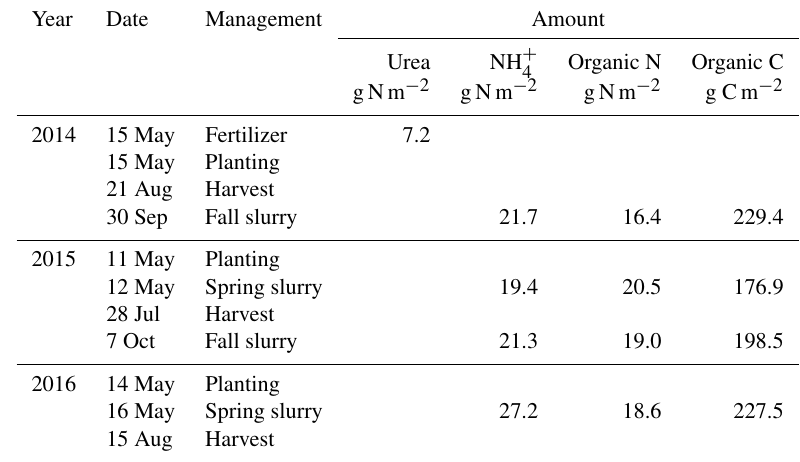
∗ From Saxton et al. (1986). Table 3. Plant and soil management schedule at the Edmonton South Campus